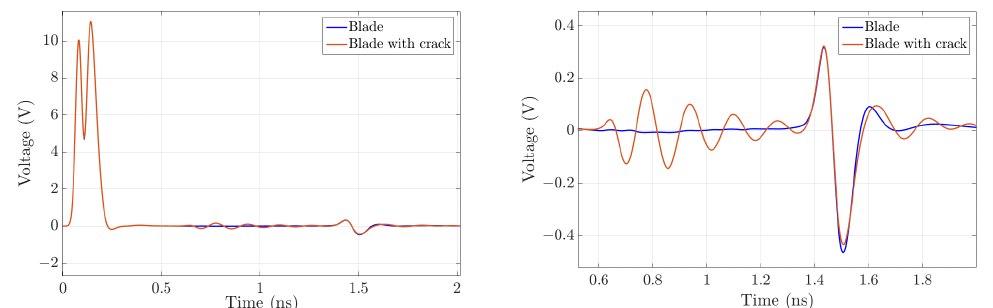
Figure 27. Comparison between the reflected voltage in the undamaged rotor blade and the cracked rotor